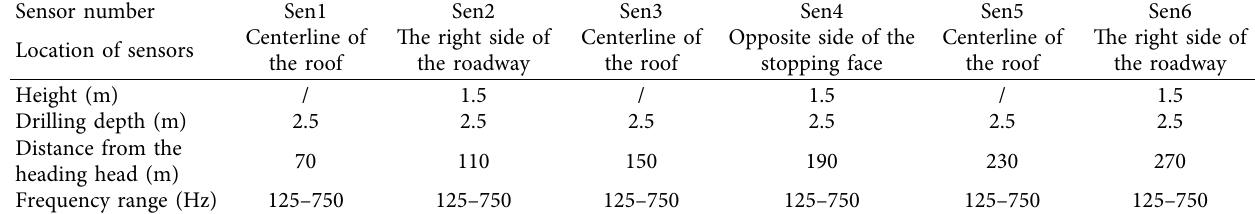
Table 2: Sensor layout parameters.